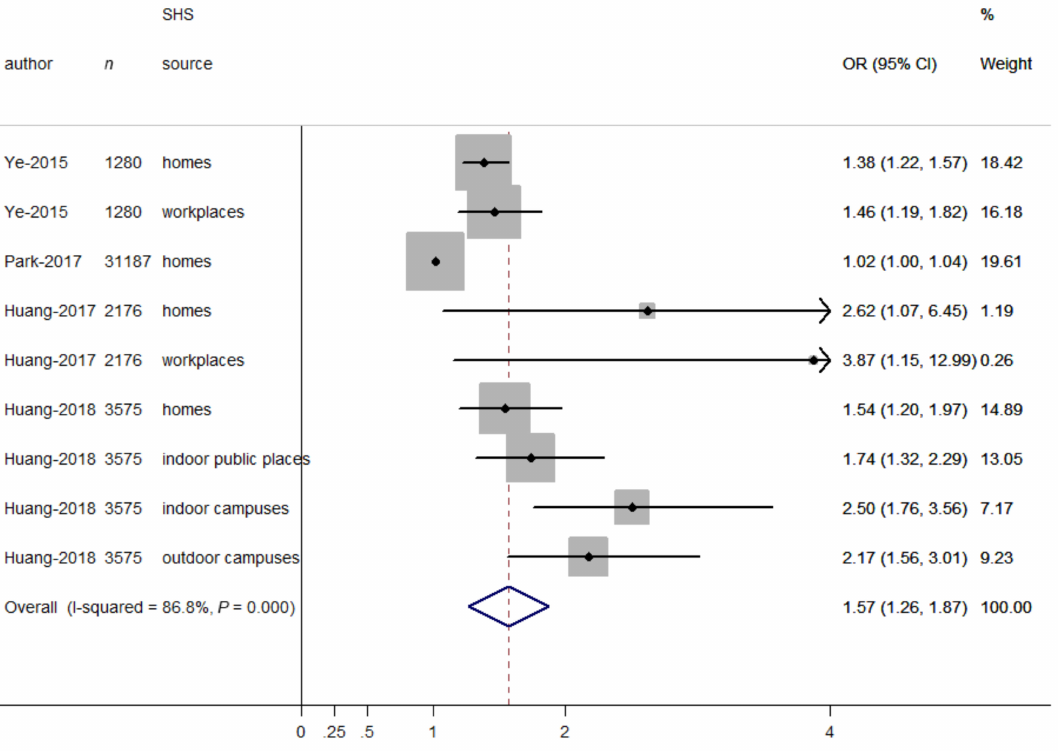
Figure 3. Forest plot for the association between SHS exposure (days / week) and depressive symptoms. Grey square represents the e ff ect estimate in each study, with square size reflecting the study-specific weight and the 95% CI represented by horizontal bars. The diamond indicates the summary e ff ect